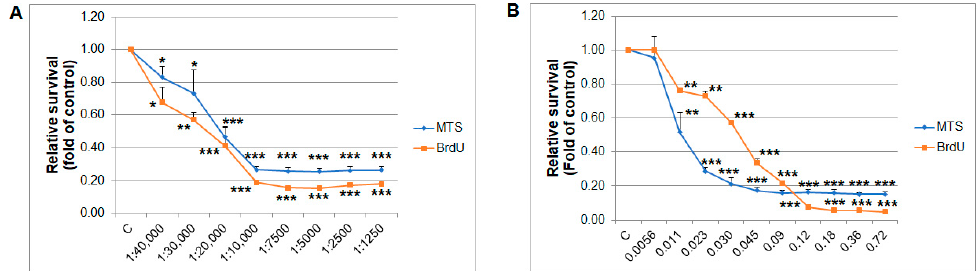
Figure 9. Relative survival of MCF-7 ( A ) and MDA-MB-231 ( B ) cells treated with EOC (1:1250-1:40,000 / 160,000) and analyzed by MTS and BrdU incorporation assays. Data were obtained from three independent experiments and significant differences were marked as p < 0.05 (*), p < 0.01 (**), p < 0.001 (***) vs. control cells (untreated).